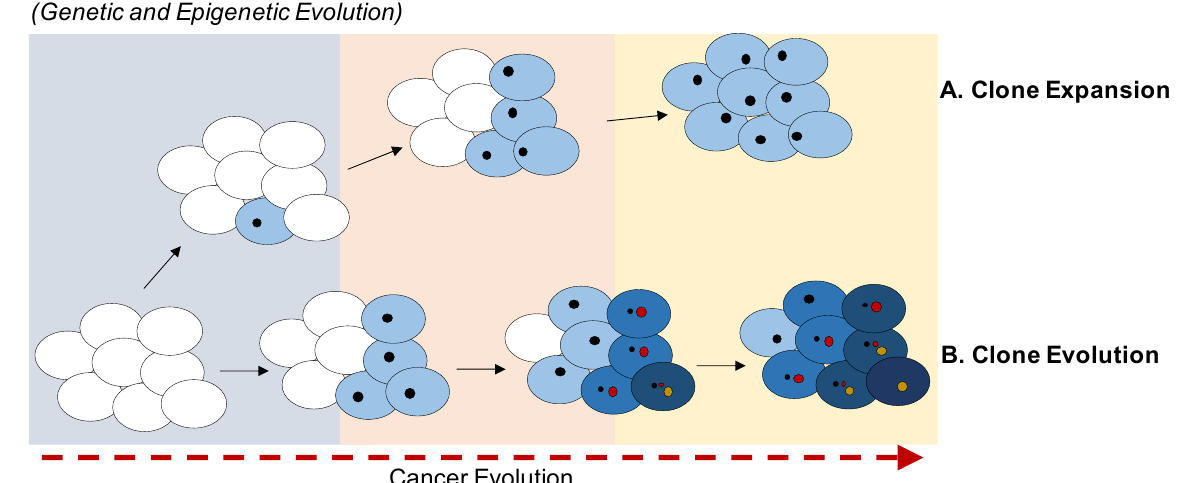
Figure 1. Evolution of cancer clones. Schematic representation of the evolution of clones based on the accumulation of genetic and epigenetic variants. Cancer cells acquire different mutations over time under environmental pressure, whereas DNA methylation is passed on to the offspring to balance oncogene-induced senescence. ( A ) Schematic representation of the expansion of a clone in which all cells share same genetic and epigenetic variants. ( B ) Schematic representation of the evolution of clones based on the acquisition of new variants. The higher fitness is shown as a darker tone. Each clone acquires different genetic and epigenetic variants, randomly generated but selected by the microenvironment and DNA-damaging therapies.